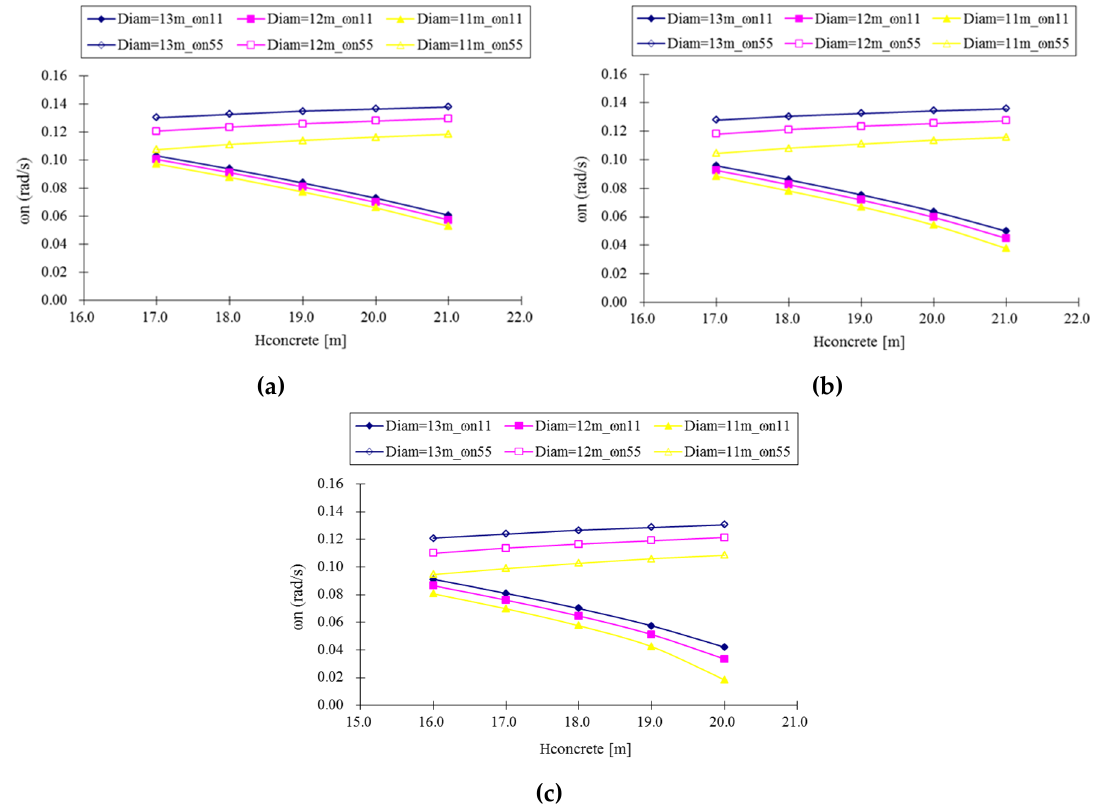
Figure 8. Surge and pitch natural frequencies for three cases with SWT = ( a ) 0.015 m, ( b ) 0.0253 m, ( c ) 0.045 m. Table 8. Heave natural frequencies of optimized